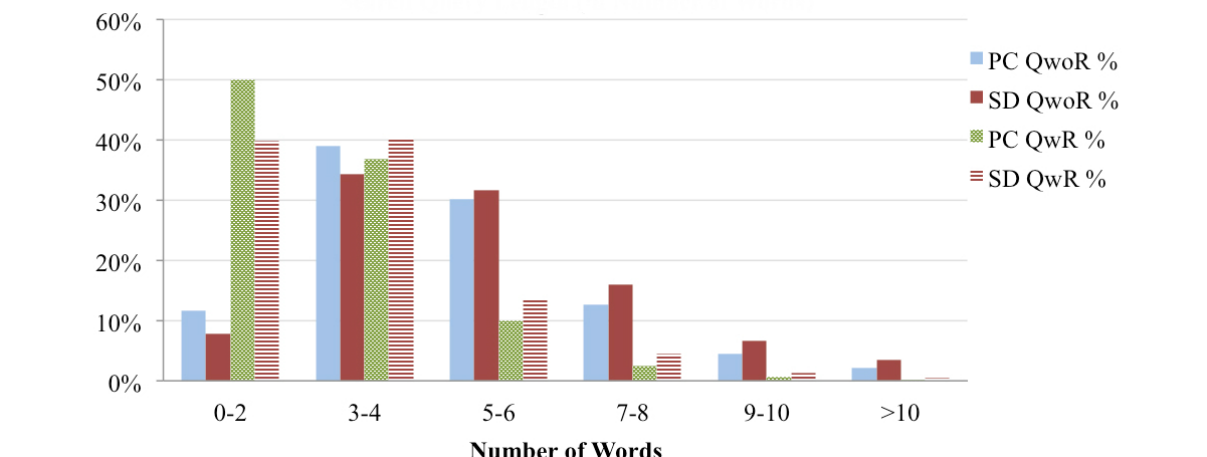
Smart devicePersonal computers